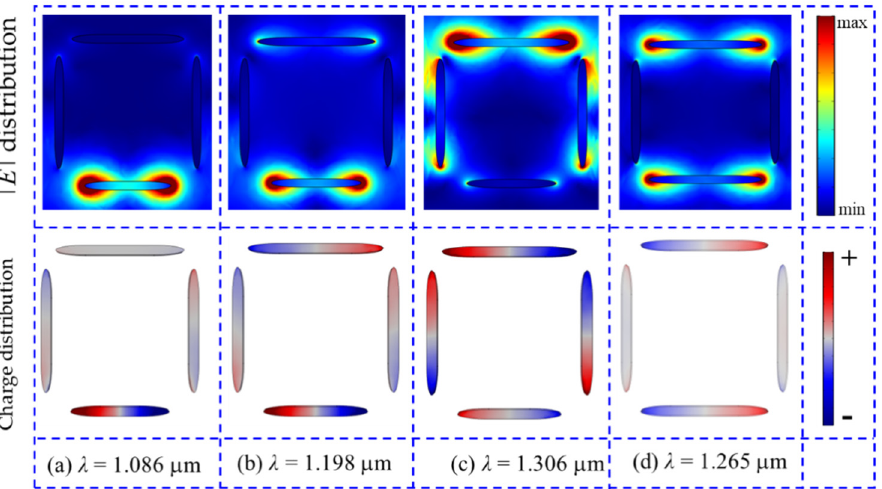
Figure 3. The electrical field | E | and surface charge distributions corresponding to the transmission peak ( λ = 1.198 μ m) and transmission dips ( λ = 1.086 μ m, λ = 1.306 μ m) of the asymmetry horizontal top and bottom nanorods. The electrical field | E | and surface charge distributions corresponding to the transmission dip ( λ = 1.265 μ m) of the symmetry horizontal top and bottom nanorods. As for the Fano resonance at the longer wavelength, the influence of coupling strength on it is firstly investigated by changing the coupling distance. The transmission spectra with a different s 1 is shown in Figure 4a, with l 1 = 260 nm, l 2 = 200 nm, d = 320 nm, and s 2 = 40 nm. During the decrease in s 1 , the Fano resonance profile at the long wave ‐ length becomes increasingly obvious and the transmission dip D 2 has a slight blue ‐ shift, but D 2 no shift. To study the formation mechanism of the new Fano resonance, the distri ‐ butions of the charge and the electric field at different incident wavelengths (I: λ = 1.385 μ m, II: λ = 1.462 μ m, and III: λ = 1.518 μ m) in the transmission spectrum with s 1 = 220 nm are simulated, as shown in Figure 4b. For λ = 1.385 μ m, the electrical field is mainly dis ‐ tributed at the two ends of the horizontal bottom nanorod and the vertical nanorods. The